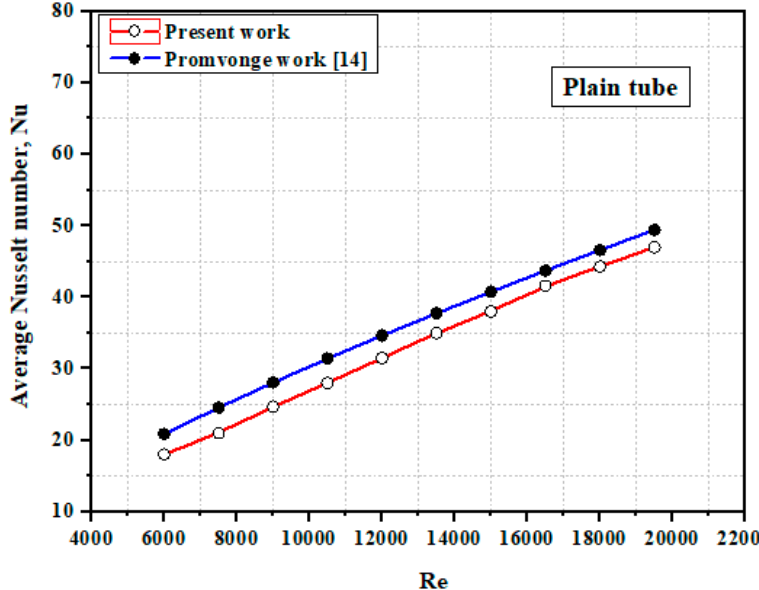
Figure 4. Confirmation of Nusselt number for plain heat exchanger.